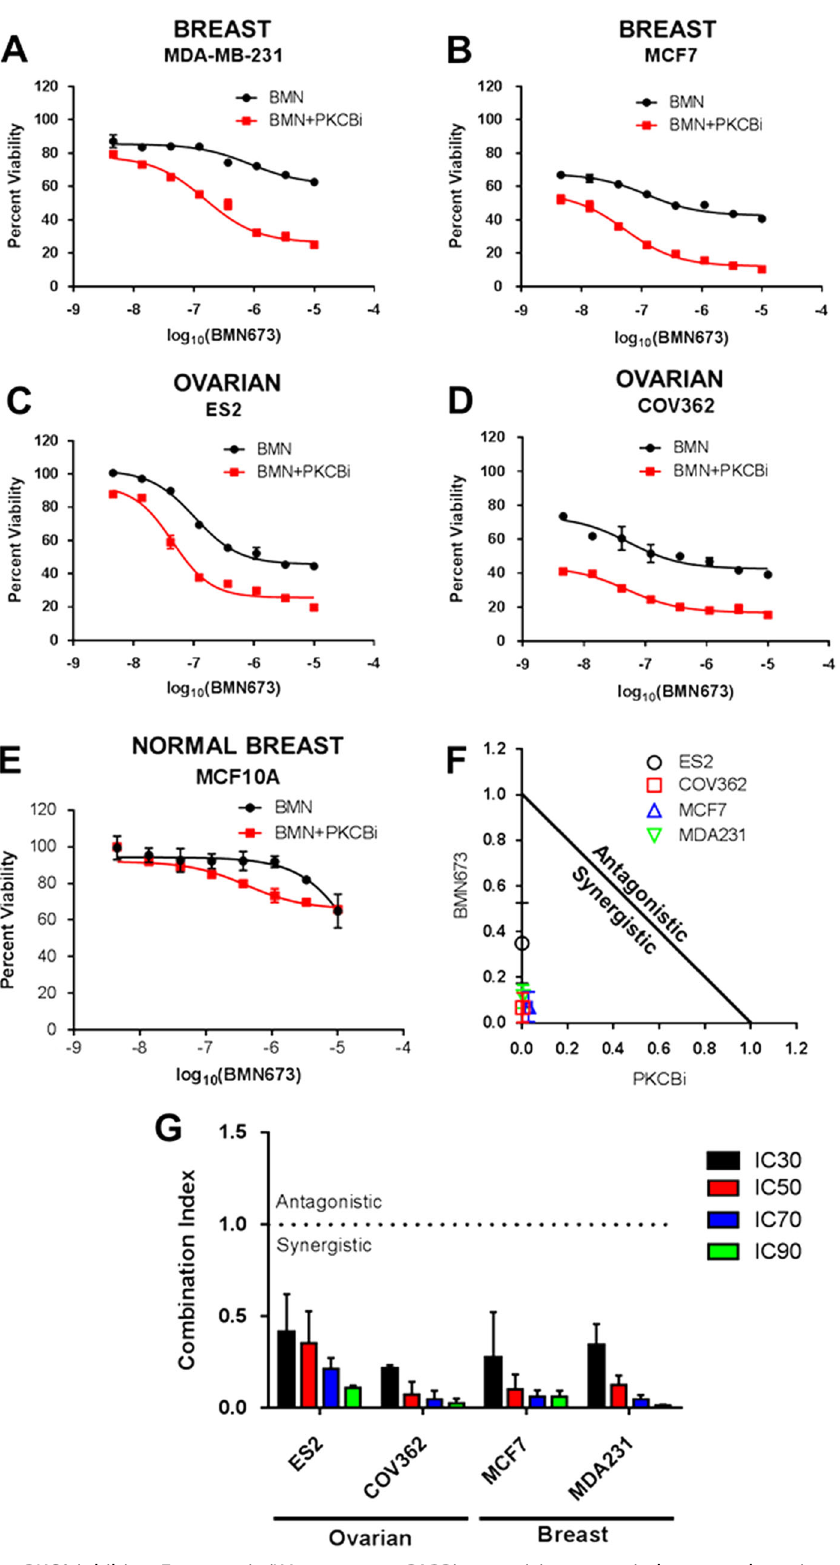
Fig. 4 Identi fi cation of the PKC β inhibitor Enzastaurin/LY317615 as a PARPi synergizing agent in breast and ovarian cancer cells. a – e Viability curves following BMN673 treatment with or without the PKC β inhibitor LY317615 at a constant molar ratio of 1:3 BMN673:LY317615 for 5 days in the breast cancer cells a MDA-MB-231, and b MCF7, and in the ovarian cancer cell lines c ES2 and d BRCA-mutant COV362, as well as in the e non-transformed mammary epithelial cell line MCF10A. f Isobolograms calculated at IC 50 values for cancer cell lines demonstrate synergism for all analyzed lines. g Combination indices demonstrate synergism between PARPi and PKC β i in a panel of ovarian and breast cancer cell lines across a range of inhibitor